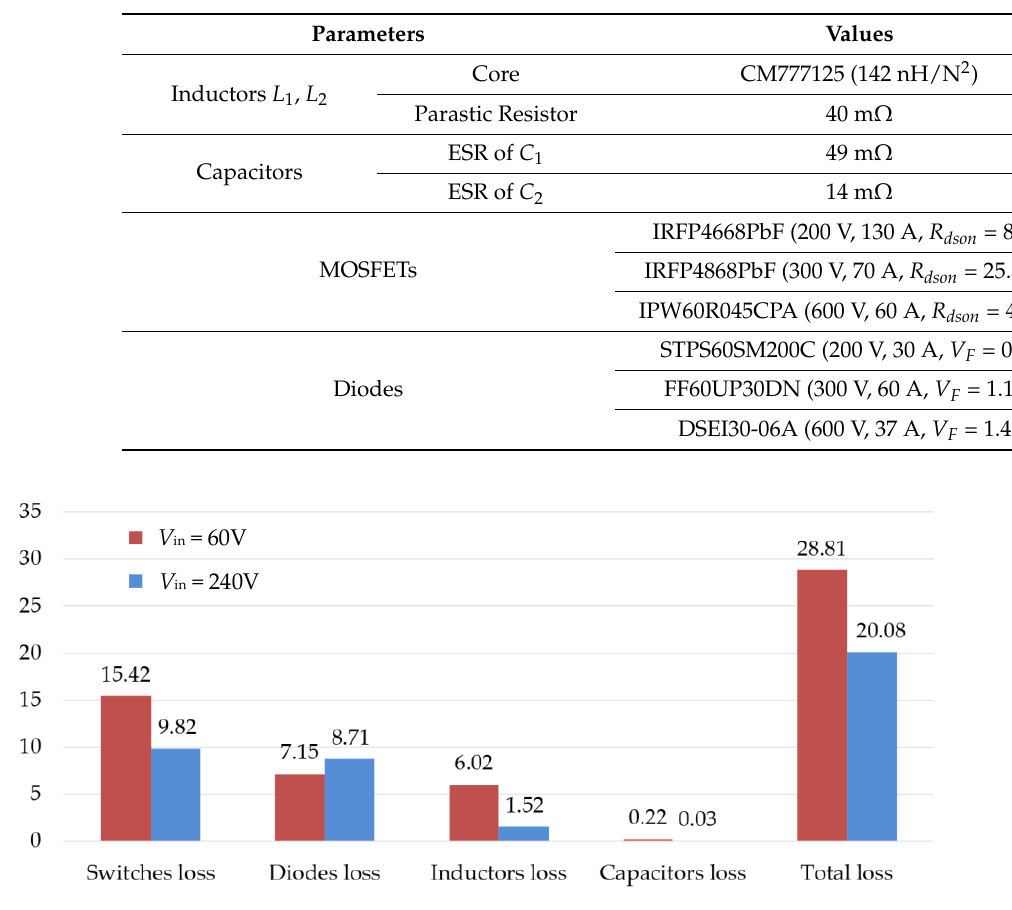
Figure 11. Power loss distribution of the proposed CGBBI.